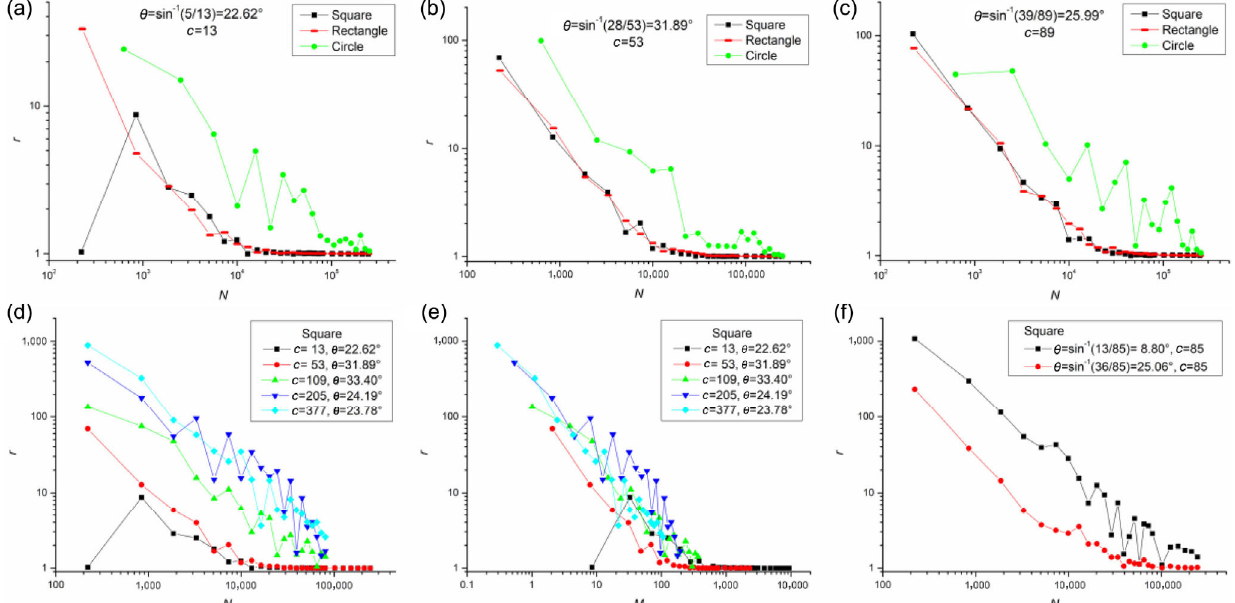
Fig. 4 Δ E ( θ , A , S ) of commensurate systems with FCC lattice. r is ratio of Δ E ( θ , A , S ) to Δ E unit ( θ ), N is number of atoms in contact area, and M = N / c is number of minimum repeat units in contact area. (a–c) show the effects of shape and size of the contact area, (d, e) show the effect of the size c of the unit cell, and (f) shows the effect of misfit angle θ . Obviously, when N becomes larger, r gradually converges to 1 in all cases. Moreover, for irregular shapes, large c and smaller θ ( θ ≤ 10°) lead to slower rate of convergence. The rate is inversely proportional to c and is more sensitive to shape and θ .